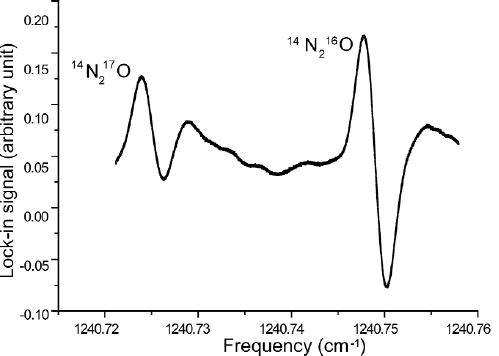
Fig. 5. First-harmonic absorption spectrum of 14 N 14 N 17 O and 14 N 14 N 16 O (0.37‰ and 99%, respec- tively). The N 2 O pressure was equal to 80